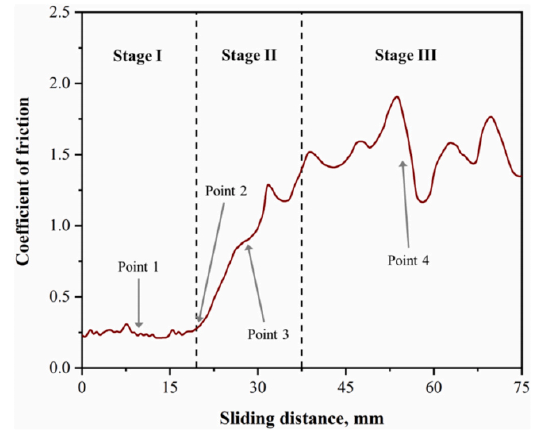
Fig. 21 COF evolution at the elevated temperature of 300 with ℃ the speed of 50 mm/s and contact load of 5 N [242]. Reproduced with permission from Ref. [242], © Elsevier Ltd., 2021.